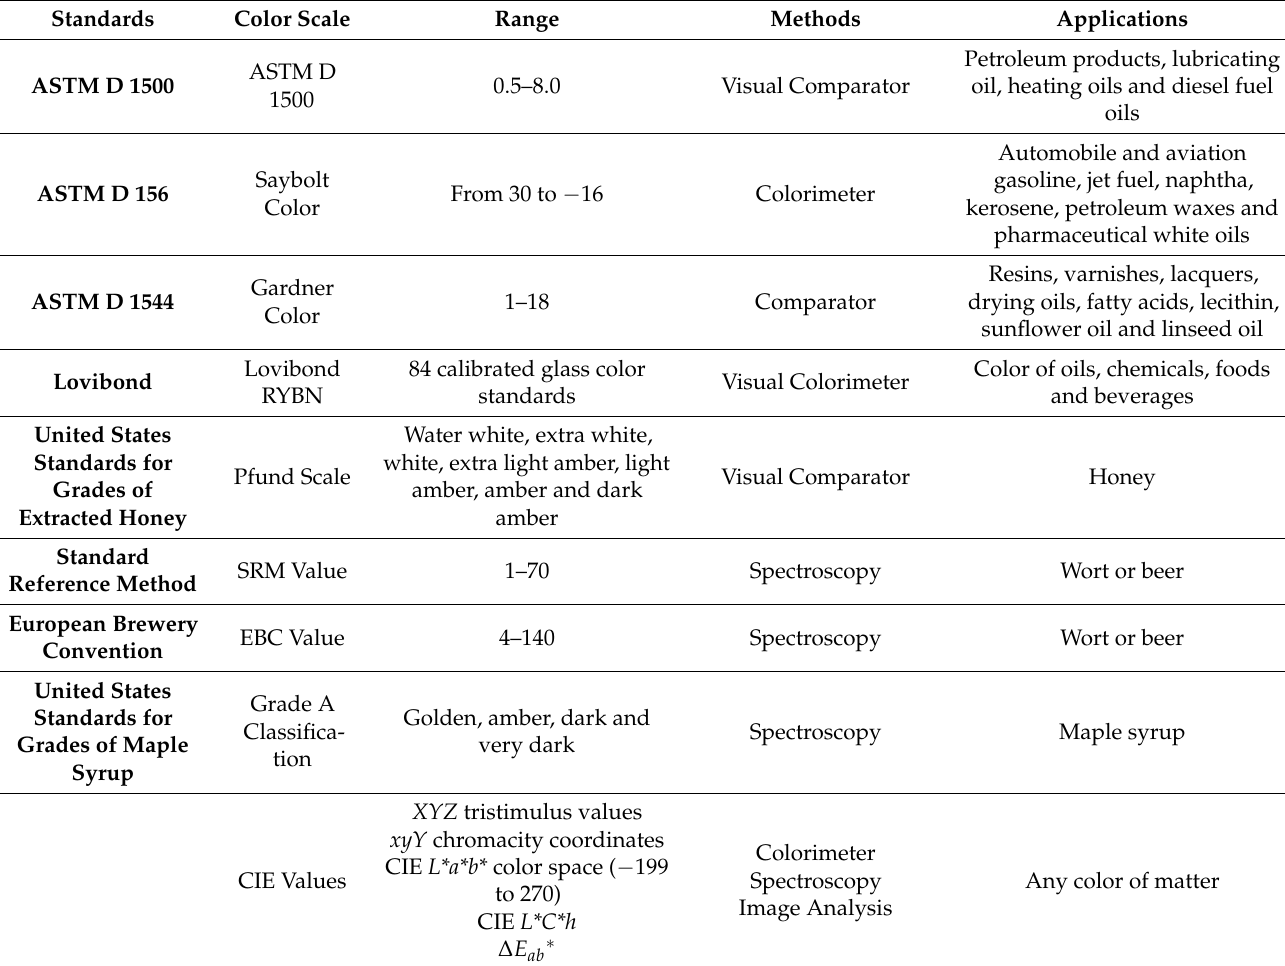
Table 7. Color standards used in color determination of amber-colored